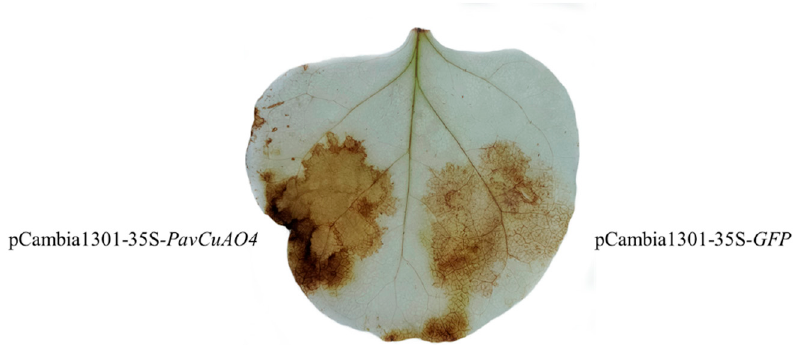
Figure 12. H 2 O 2 content of tobacco leaves with transient expression of PavCuAO4.